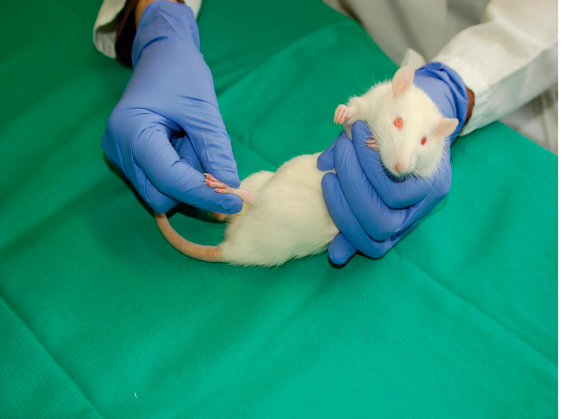
Figure 4. Manually assisted locomotor (ML) therapy, passive flexion–extension (PFE) exercise. The conditioning started 2 weeks prior to SCI and post-injury treatment started on day 14 after SCI. Each ML (PFE) treatment session consisted of a total of 80 alternating passive flexions and extensions in all three joints of the hindlimbs (i.e., hip, knee, and ankle joints).